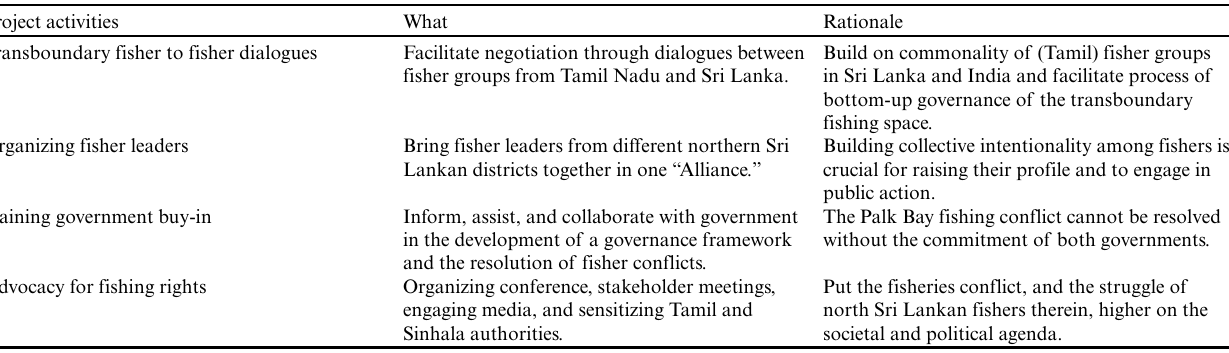
Table 1 . Project activities and their